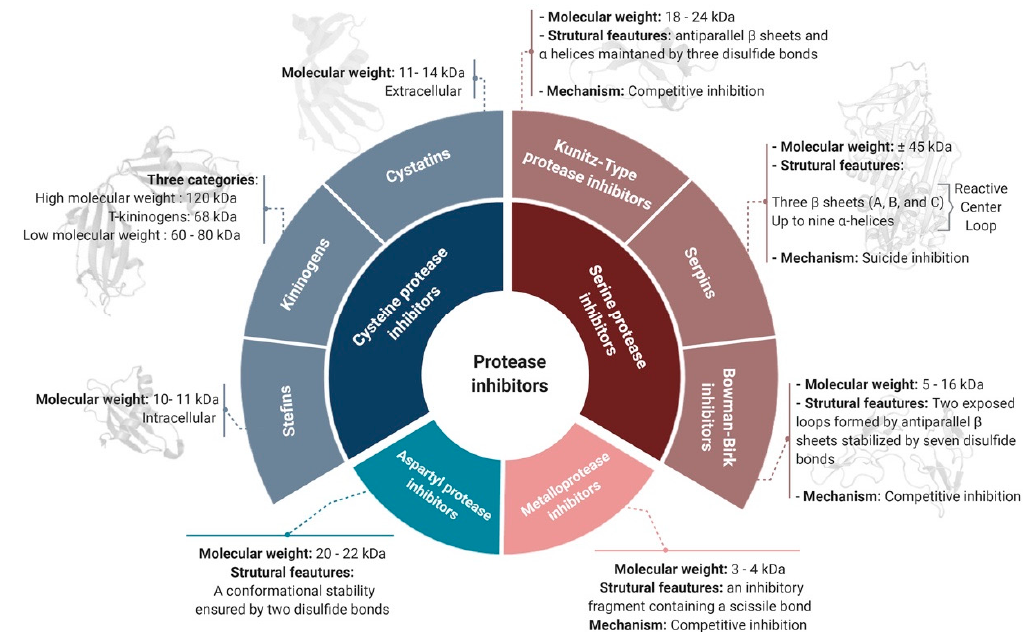
Figure 1. The target-based classification of protease inhibitors.